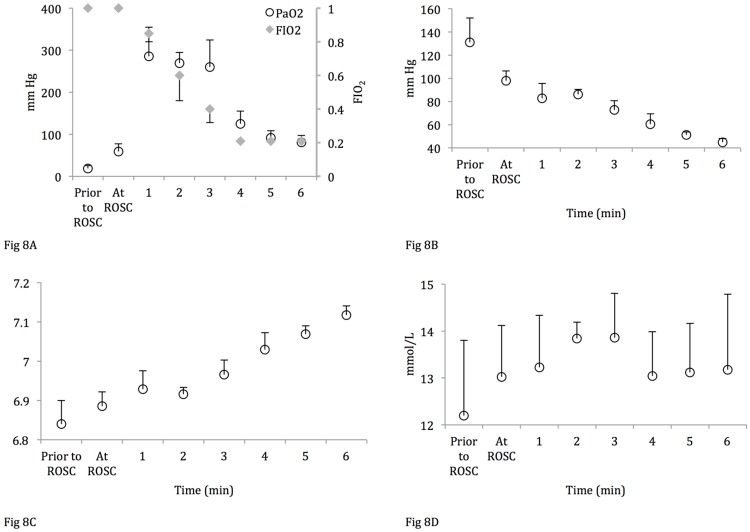
Comparison of arterial blood gas analysis following ROSC.(A) PaO2; the secondary y-axis represents FIO2, (B) PaCO2, (C) pH, (D) Lactate. Data are mean ± SEM bars.